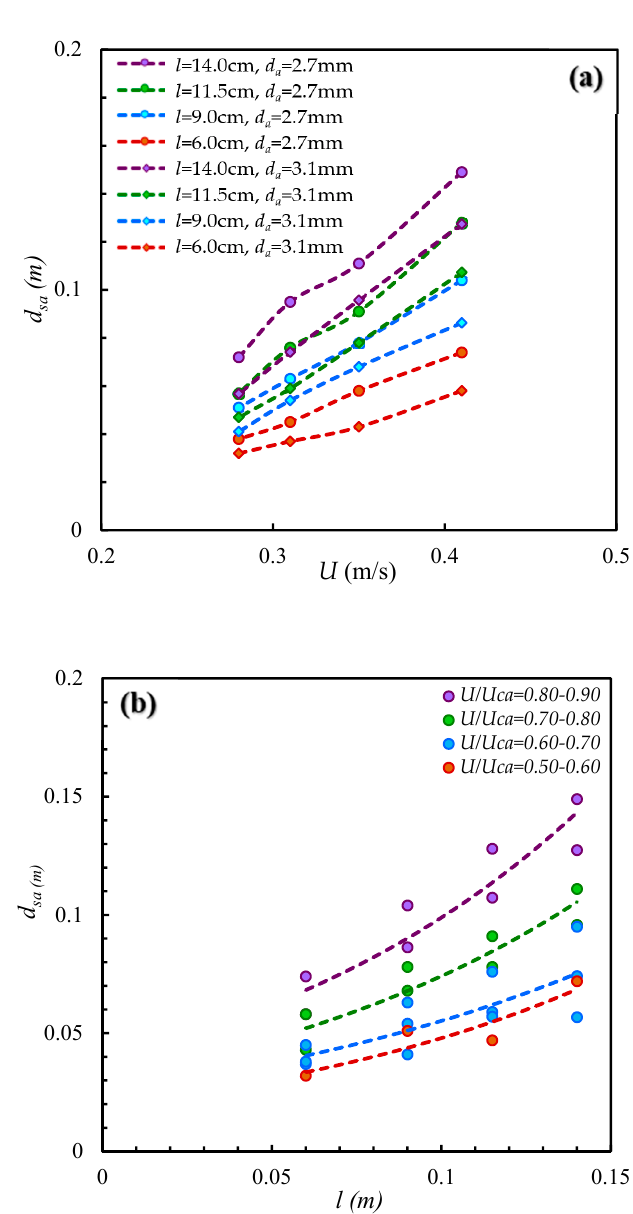
Figure 4. Maximum scour depth of spur dike ( a ) Depth with time-averaged velocity, and ( b ) Depth with transverse